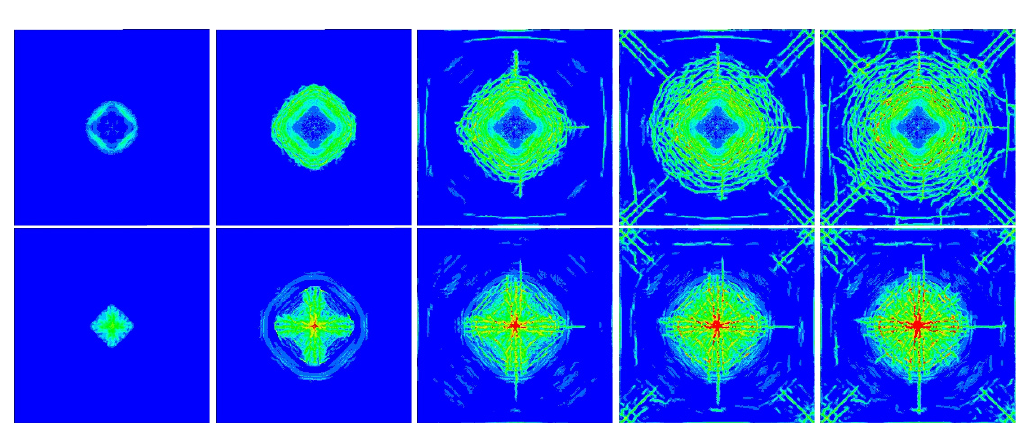
Figure 7. The time-evolution of the damage map for the top face (top row) and bottom face (bottom row) of the fourth layer. From left to right, snapshots taken at 27, 43, 79, 127, and 161 µ s from the contact between the projectile and the glass laminate. See movie 4 for the top face.